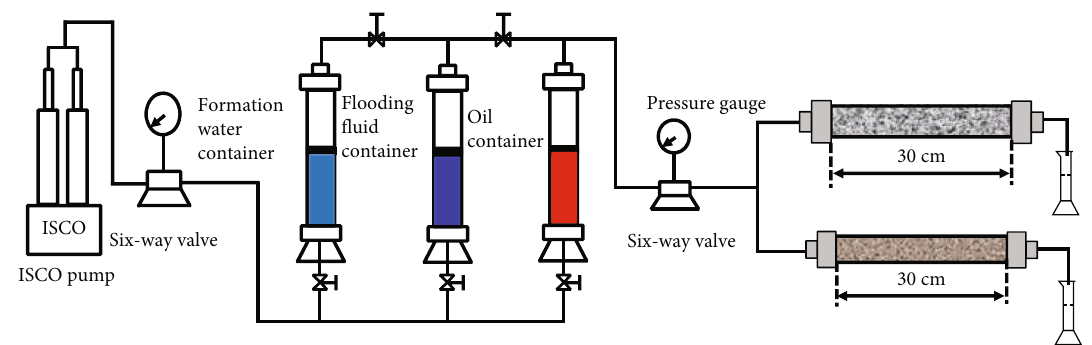
Figure 1: The schematic diagram of parallel sand pack fl ooding experimental apparatus. Table 2: The porosity and permeability of sand packs used for fl ooding experiments. Test no.